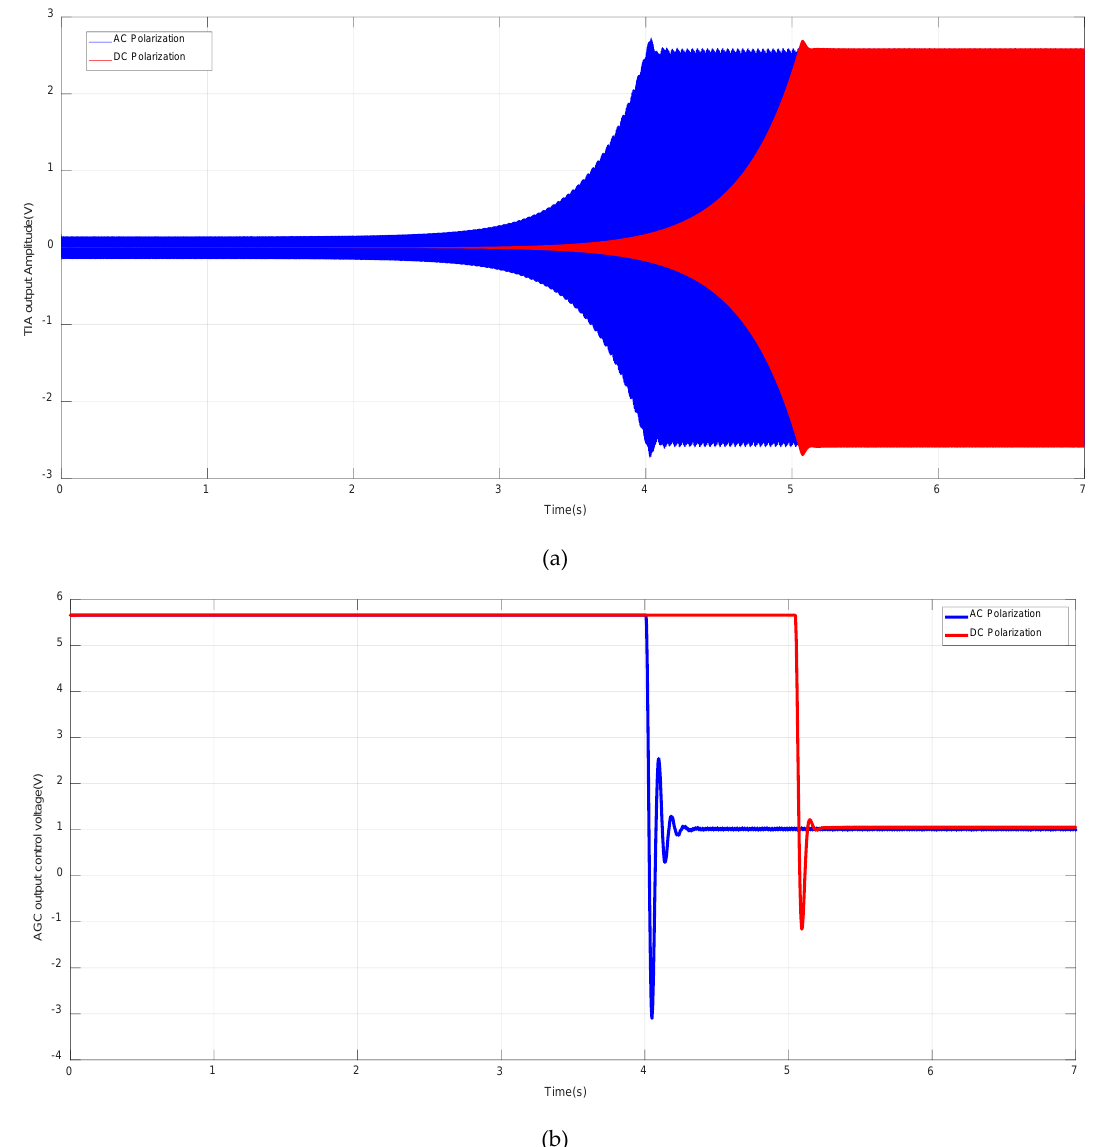
Figure 6. Startup process of ( a ) TIA output voltage, VDS(t) and ( b ) AGC output control voltage, Vc(t) under DC and AC polarization.